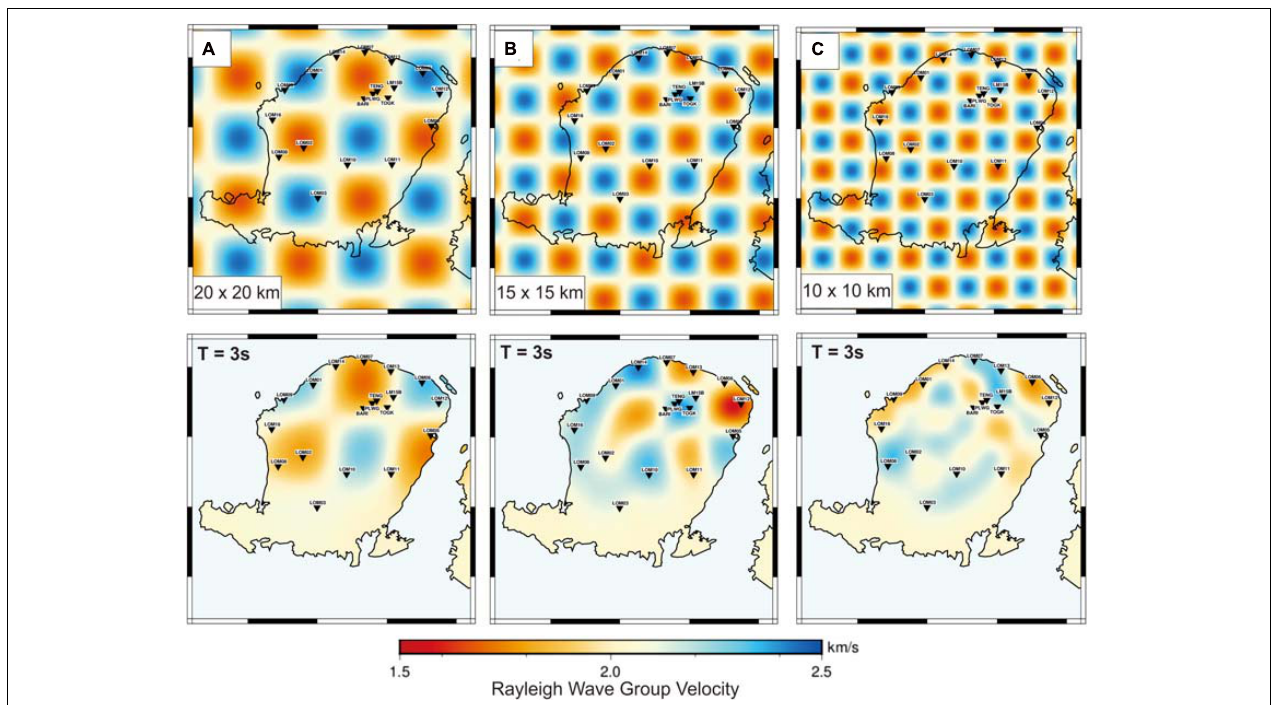
FIGURE 5 | The checkerboard test by using grid 20 × 20 km (A) 15 × 15 km, (B) 10 × 10 km, and (C) for period 3 s. Upper figures show the initial velocity model and the bottom figures show the recovery